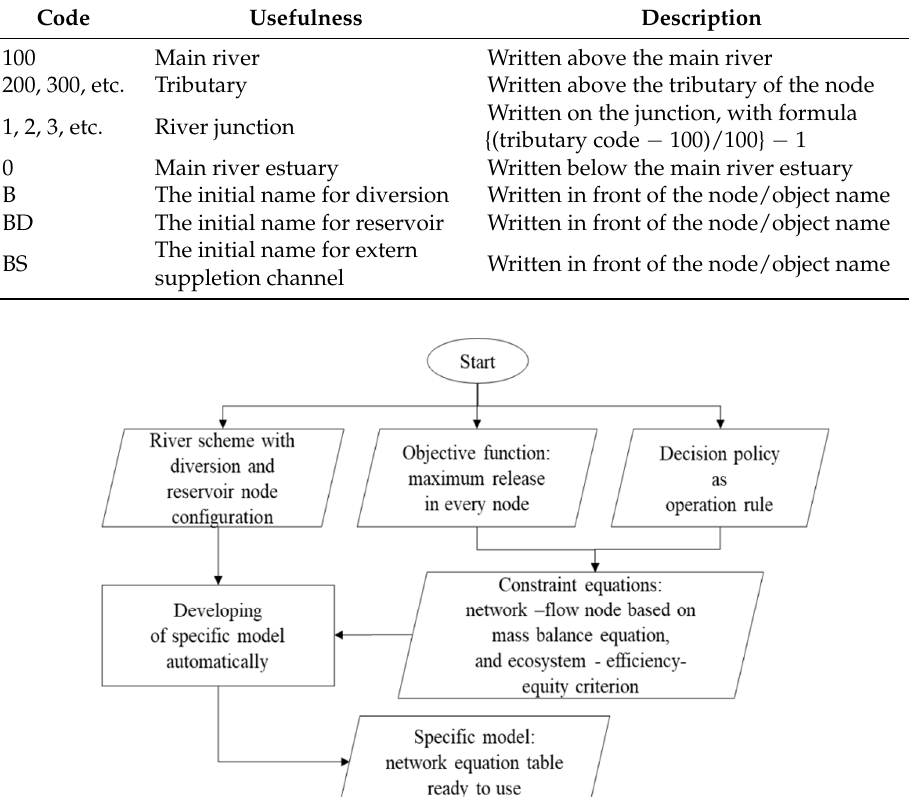
Table 2. The coding guidelines for the network-flow node in river scheme.